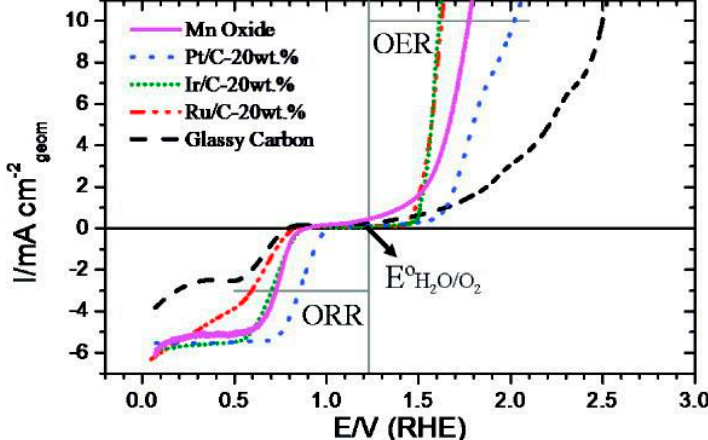
Figure 2. Oxygen electrode activities of the nanostructured Mn oxide thin film, nanoparticles of Pt, Ir, and Ru, and the GC substrate. The Mn oxide thin film shows excellent activity for both the oxygen reduction reaction (ORR) and the oxygen evolution reaction (OER). Reproduced with permission from Ref. [75]. Copyright, Journal of the American Chemical Society 2010.